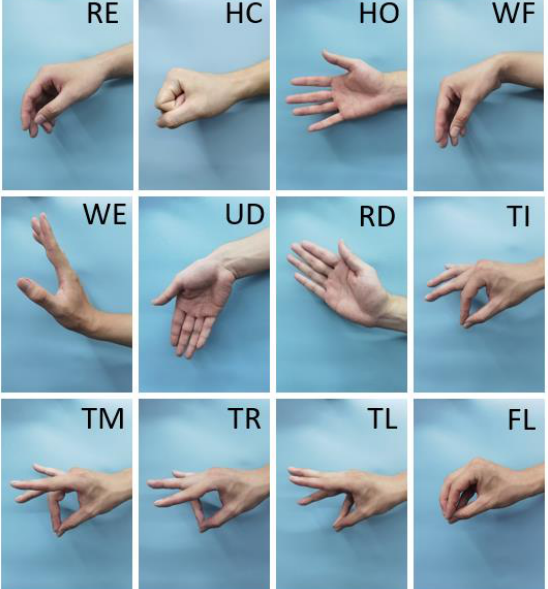
Figure 4. Hand movements. Three types of gestures were selected. Basic hand movements: HC and HO; wrist movements: WF, WE, UD and RD; finger movements: TI, TM, TR, TL and FL. In addition, a reference gesture RE.